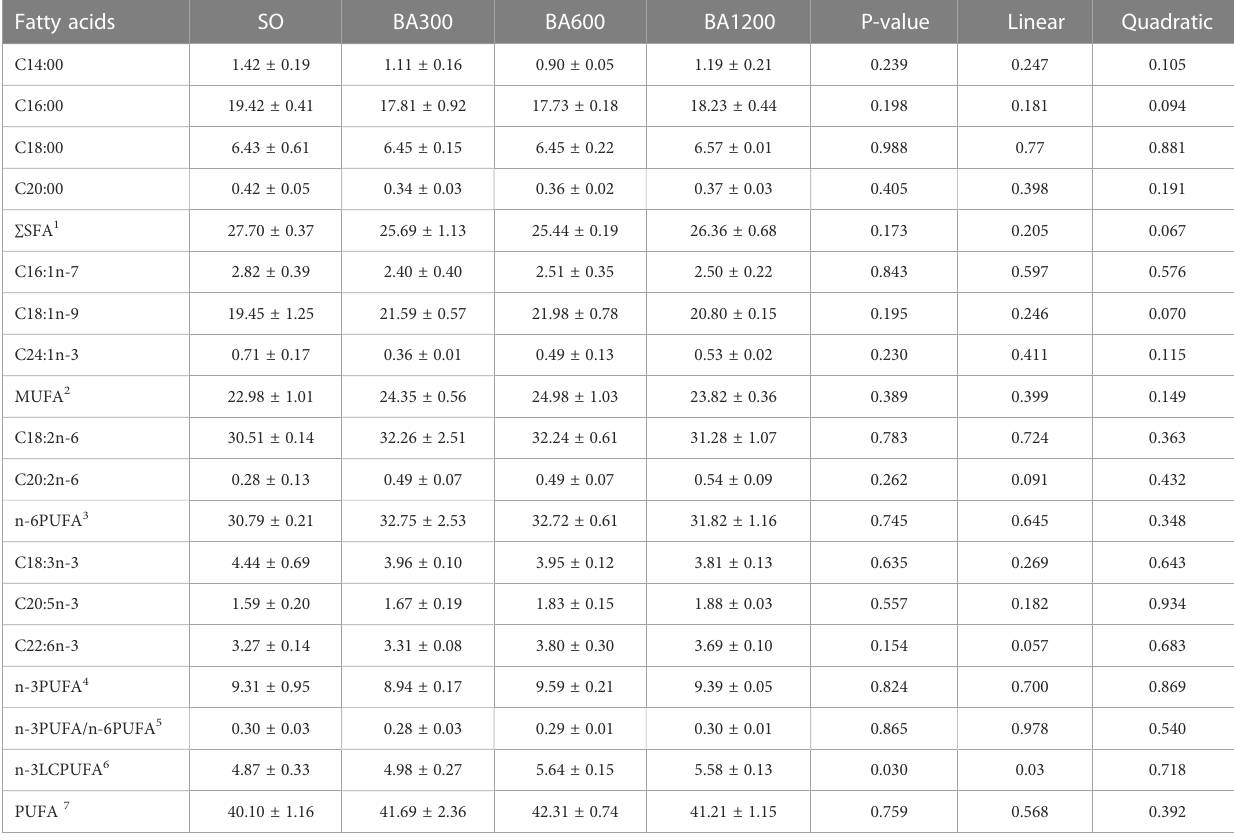
TABLE 7 Fatty acids pro fi le (% total fatty acids) in muscles of juvenile large yellow croaker in different treatments. Fatty acids SO BA300 BA600 BA1200 P-value Linear